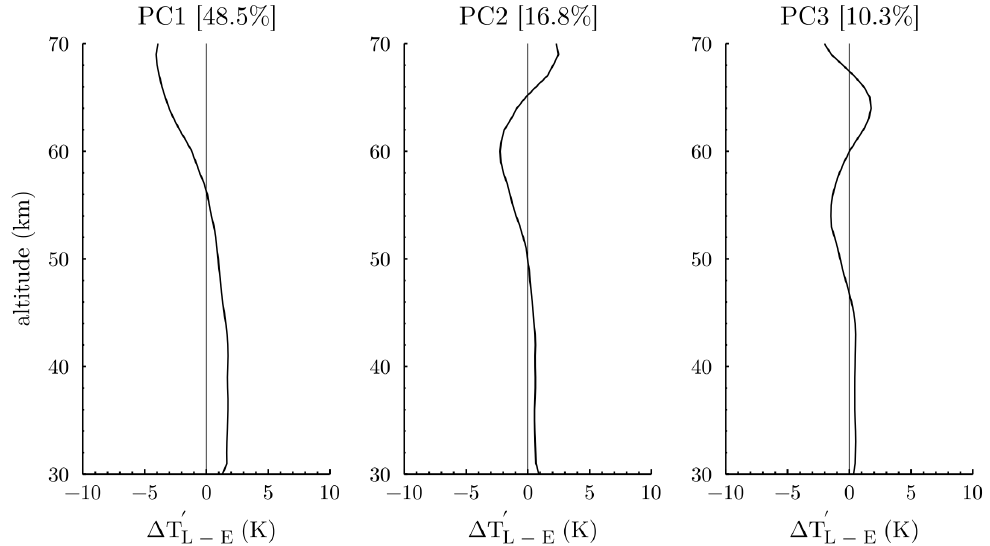
Figure 6. Vertical modes for the summer months (June, July, August) of the fluctuations of the temperature difference between the LiDAR and ERA-5, corresponding respectively to (PC1) 49%, (PC2) 17%, and (PC3) 10% of the variability.